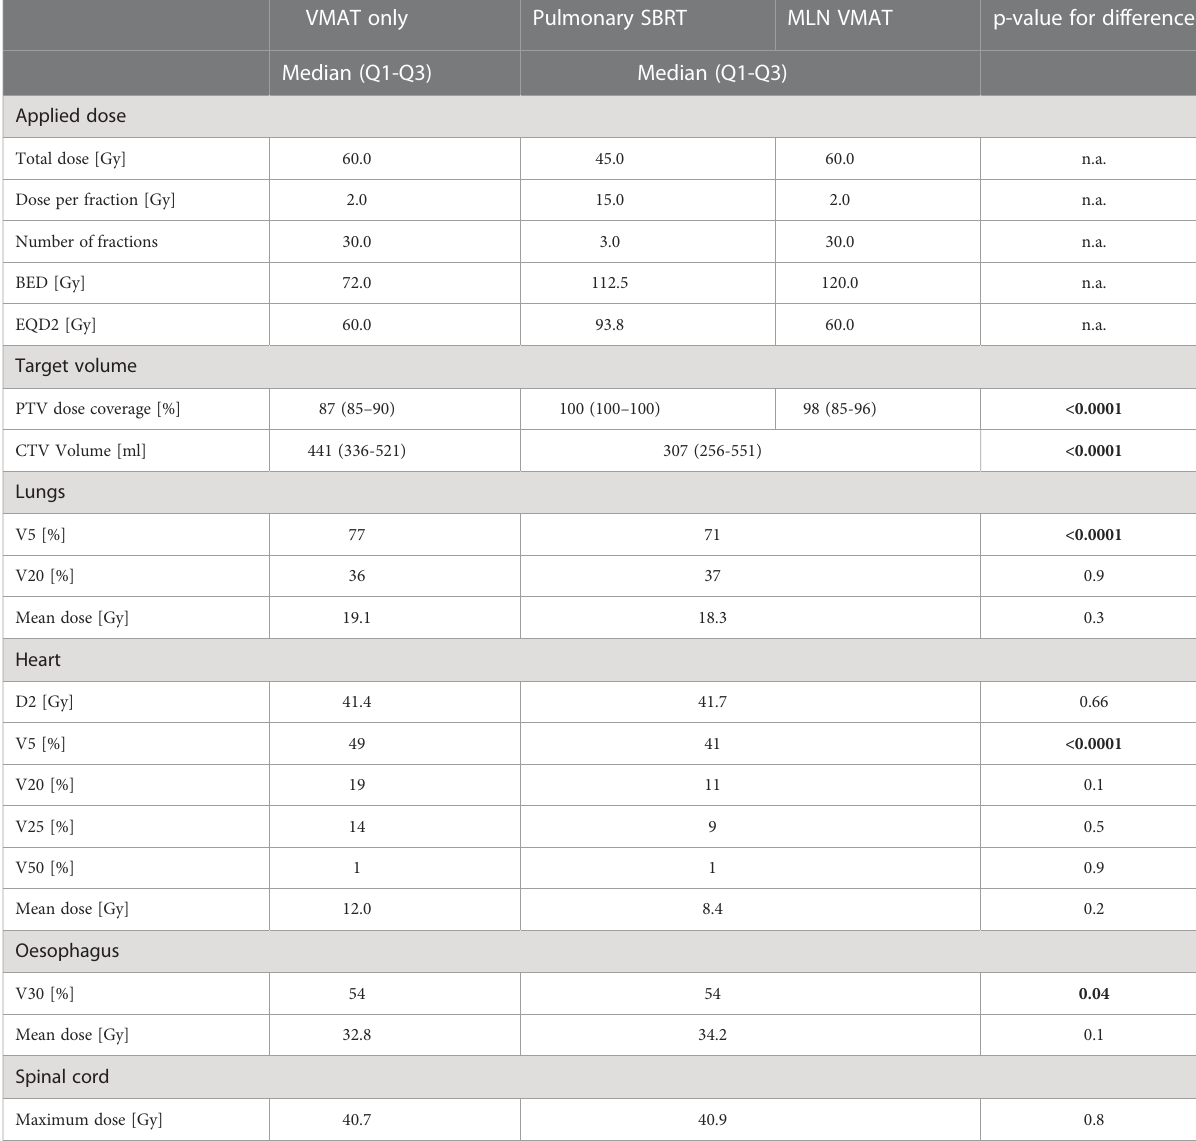
TABLE 2 Dosimetric summation comparison between combined pulmonary Stereotactic Radiotherapy (SBRT) and Volumetric Arc Therapy (VMAT) to the mediastinal lymph nodes (MLN), the SBRT+MLN approach, and both pulmonary and mediastinal VMAT, the VMAT only approach. VMAT only Pulmonary SBRT MLN VMAT p-value for